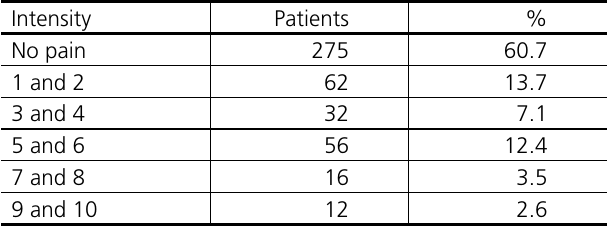
Table 1. Pain stratification by intensity from 0 to